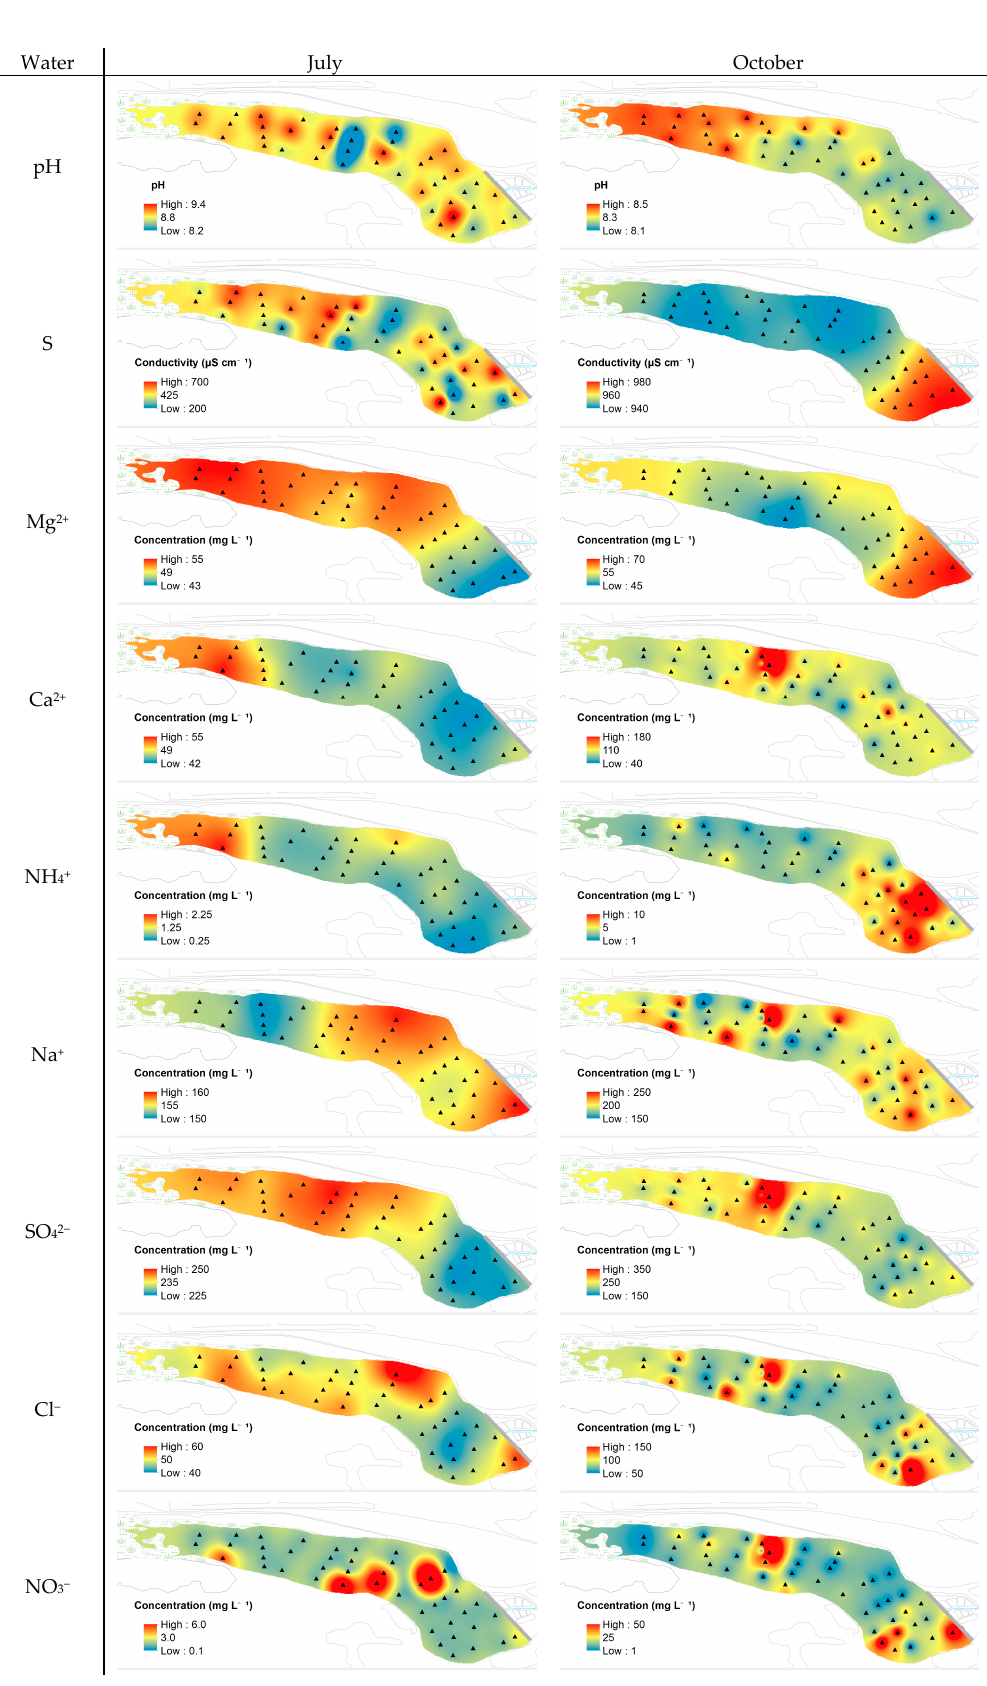
Figure 6. Spatial distribution of pH, conductivity (S), Mg 2+ , Ca 2+ , NH 4+ , Na + , SO 42 − , Cl − , and NO 3 − in water of Podu Iloaiei Dam Lake for July and October sampling sessions.